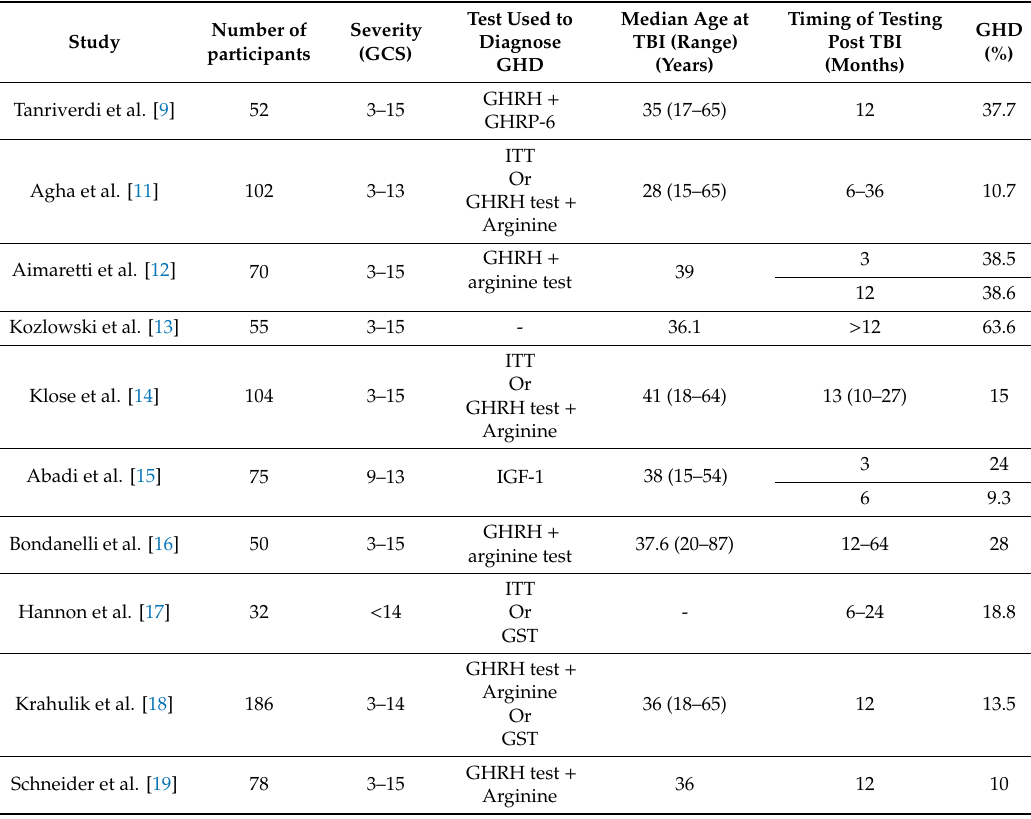
Table 2. Sample studies on the prevalence of growth hormone deficiency occurring in the chronic phase post traumatic brain